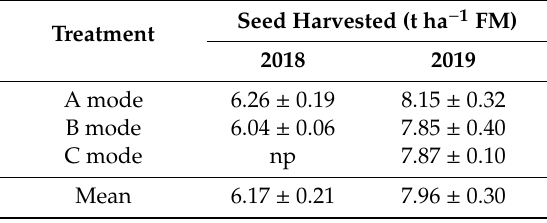
Table 7. Seed harvested according to the treatments in 2018 and 2019.